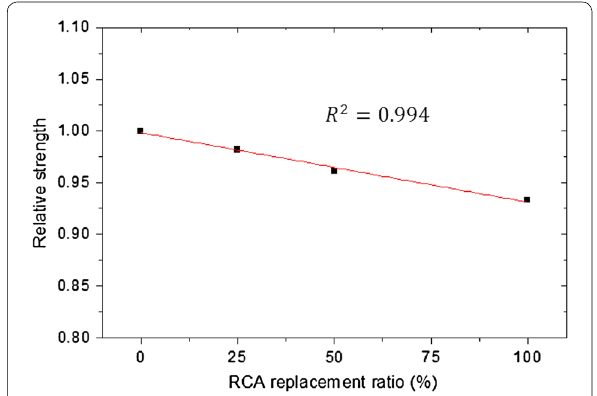
Fig. 9 Influence of RCA content on ultimate